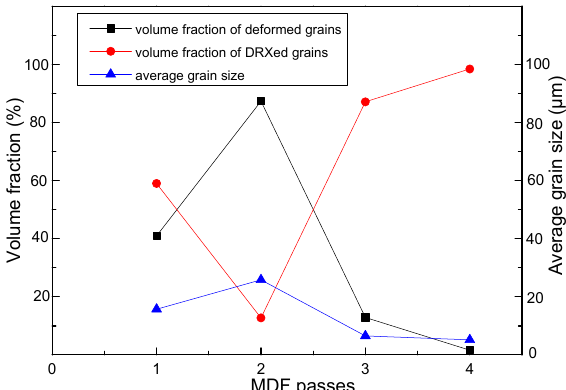
Figure 9. The trend about volume fraction of DRXed grains, deformed grains, and average grain size after different MDF passes.